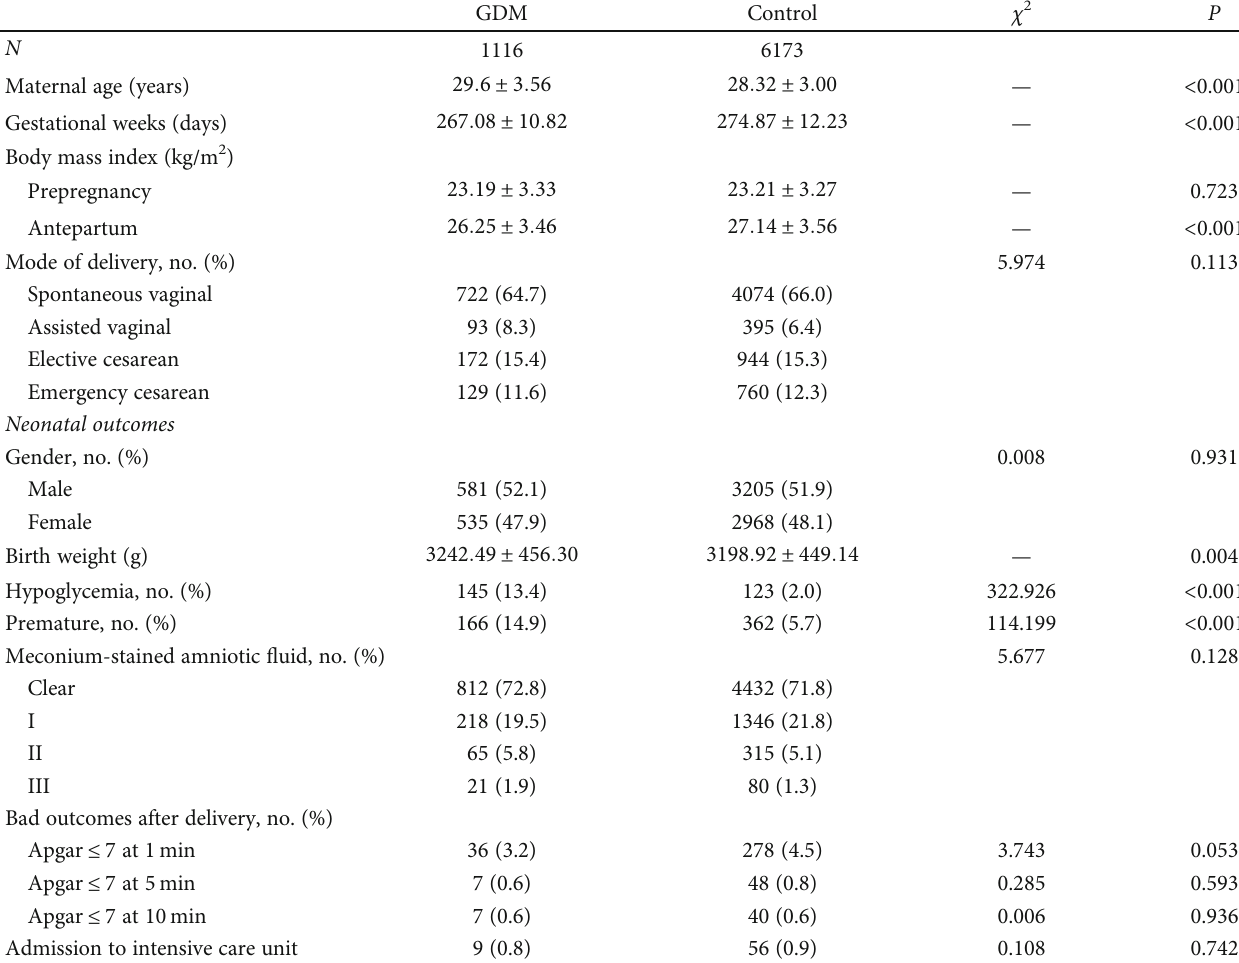
Table 1: Characteristics and outcomes of the study